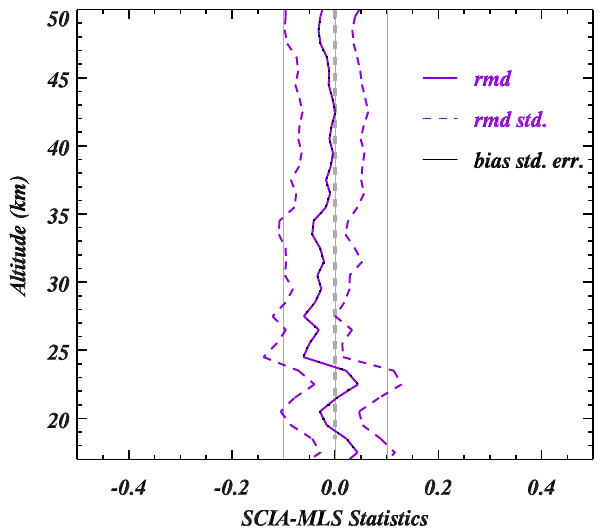
Fig. 15. SCIAMACHY–MLS comparison statistics for the period 2004–2010 based on 1321 collocations.